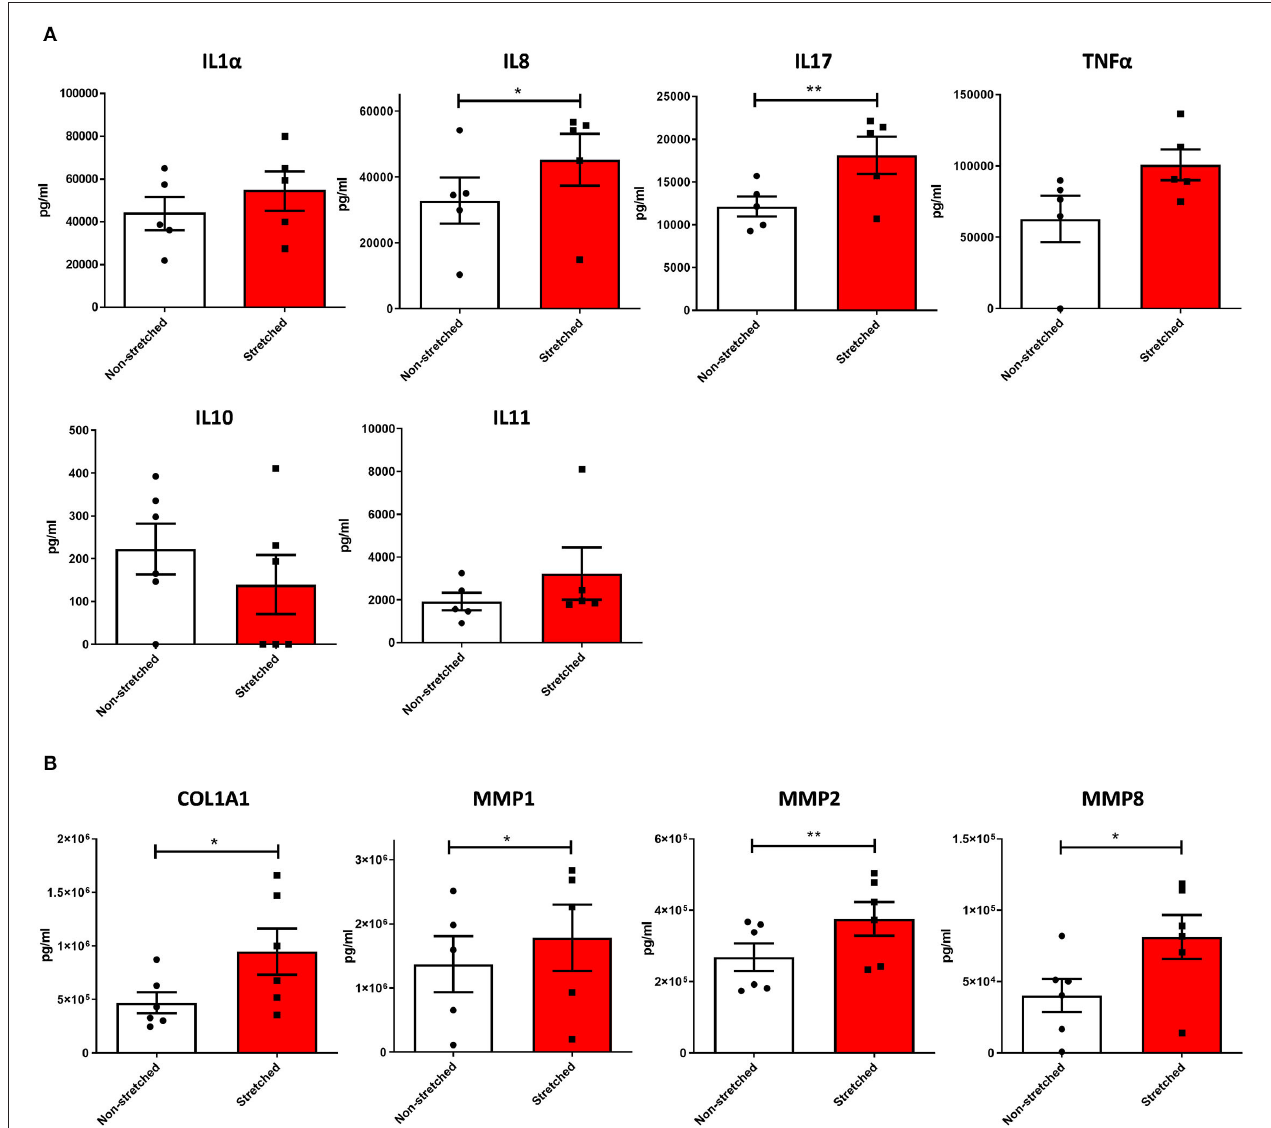
FIGURE 4 | Increased secretion of pro-inflammatory and pro-fibrotic cytokines upon mechanical stretch of C-MSC. (A) Secretome comparison of pro-inflammatory mediators of non-stretched and stretched HC C-MSC. The concentration of each factor was calculated per ml of supernatant in 72-h medium. * p < 0.05; ** p < 0.01. (B) Secretome comparison of pro-fibrotic mediators of non-stretched and stretched HC C-MSC. The concentration of each factor was calculated per ml of supernatant in 72-h medium. * p < 0.05; ** p <